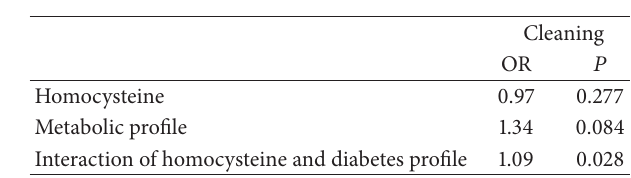
Table 5: Estimates of the binomial generalized linear model for the cleaning scale of MOCI.